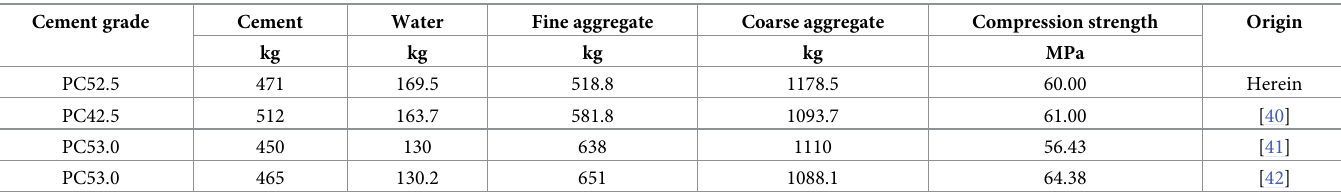
Table 2. Mix proportion designed in this study and some previous